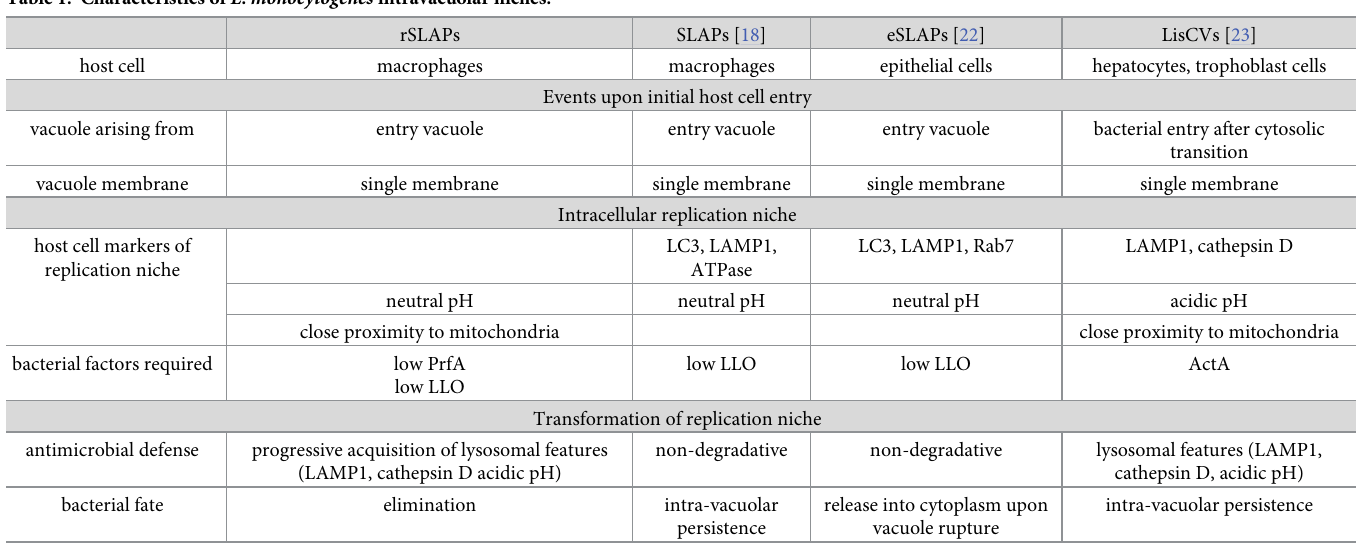
Table 1. Characteristics of L . monocytogenes intravacuolar